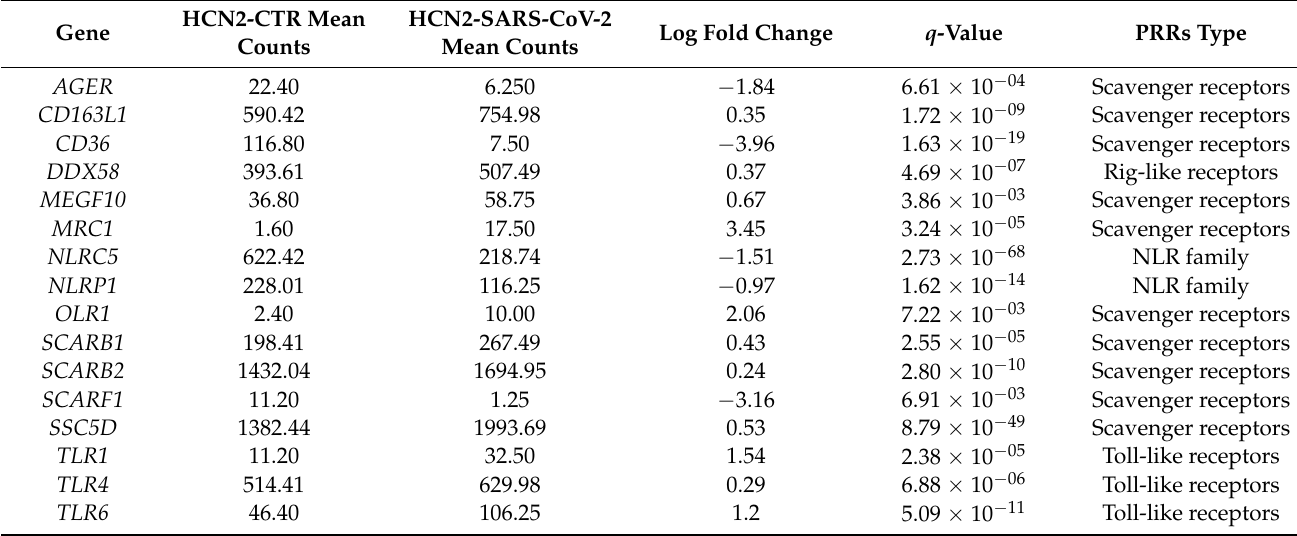
Table 1. DEGs identified as pattern recognition receptors.